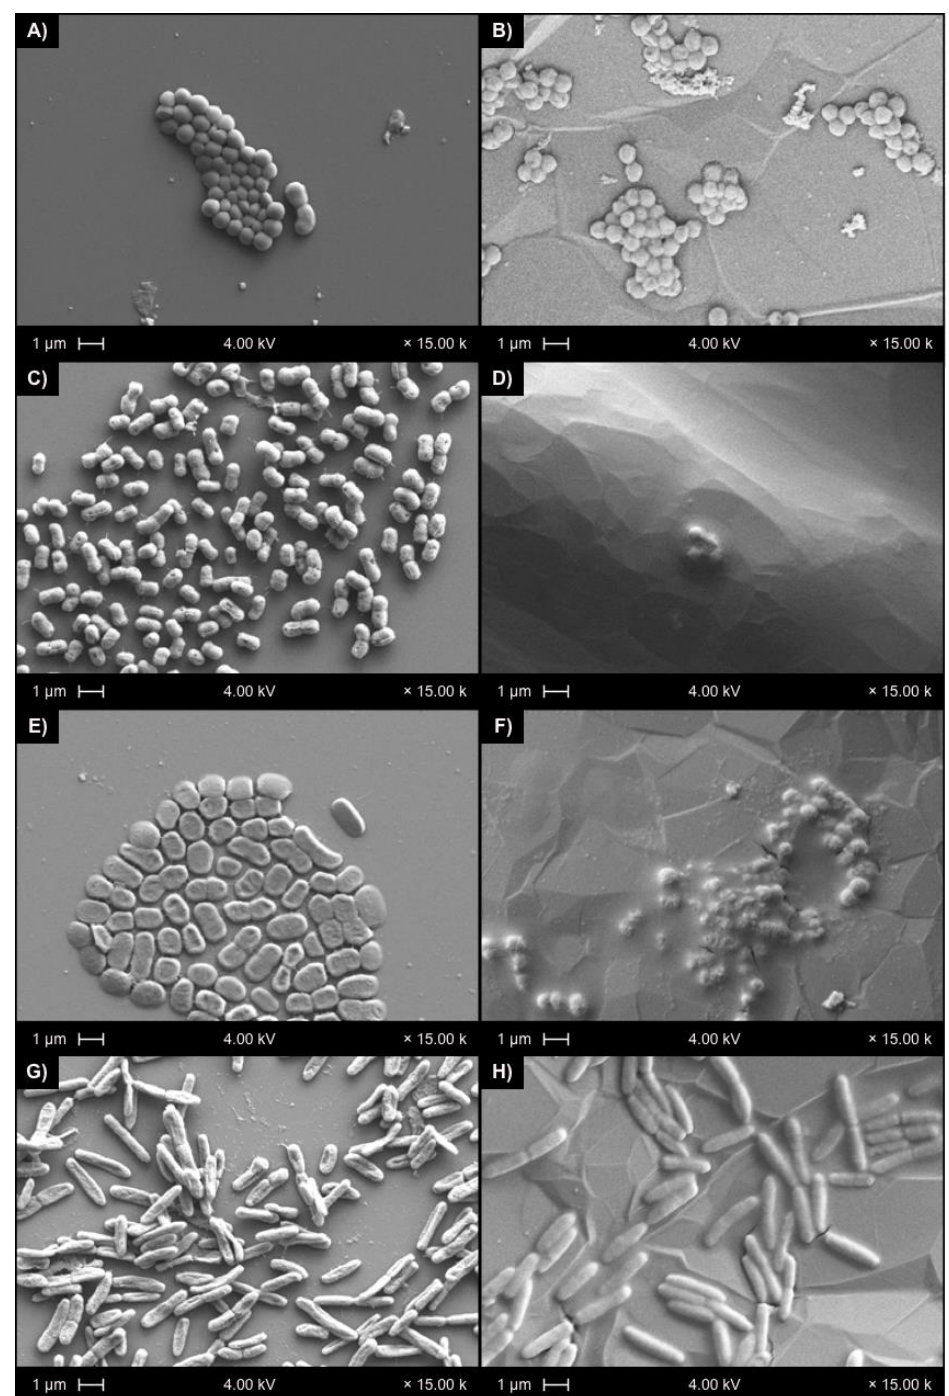
Figure 6. Comparison of the bacteria on ( A – D ) silicon and ( E – H ) graphene foam demonstrating the changes in the bacterial morphology against the resistant strains ( A , E ) S. aureus ( B , F ) K. pneumoniae ( C , G ) A. baumannii ( D , H ) P. aeruginosa .